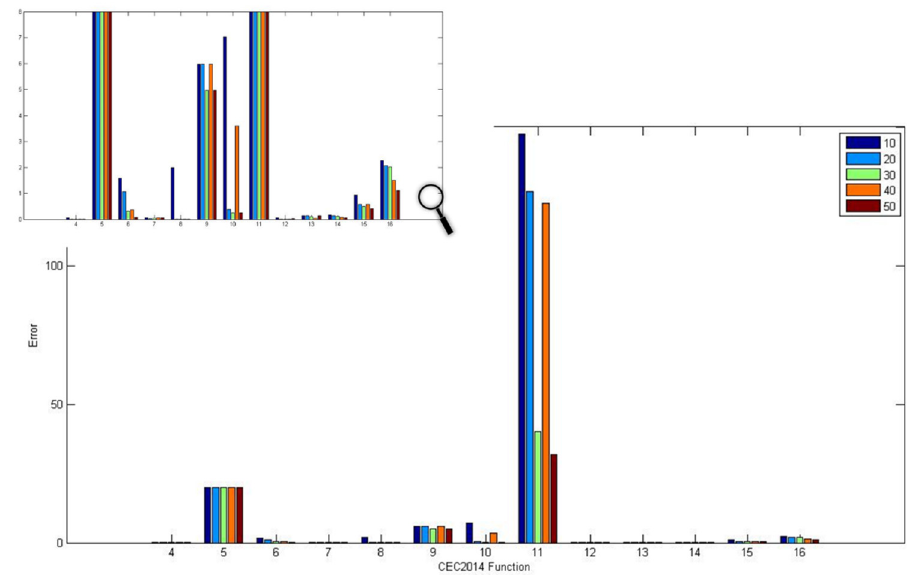
Figure 3. Fitness error of the benchmark functions with different number of agents.